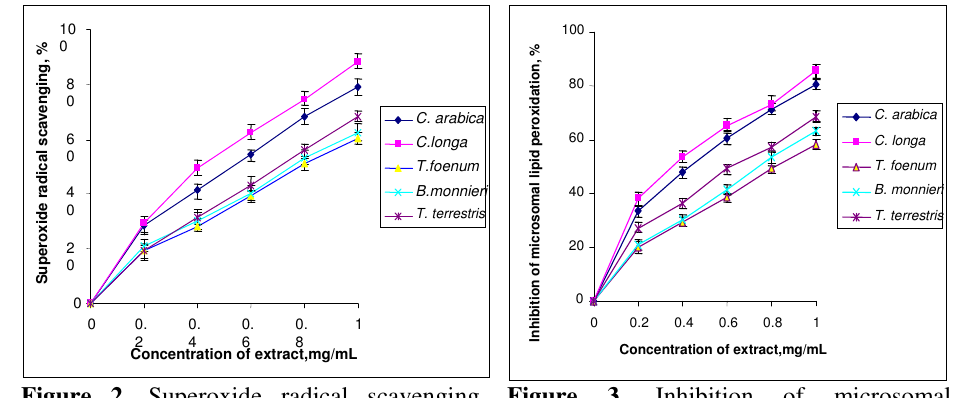
Figure 2. Superoxide radical scavenging activity data represents, mean ±SEM, for n=3